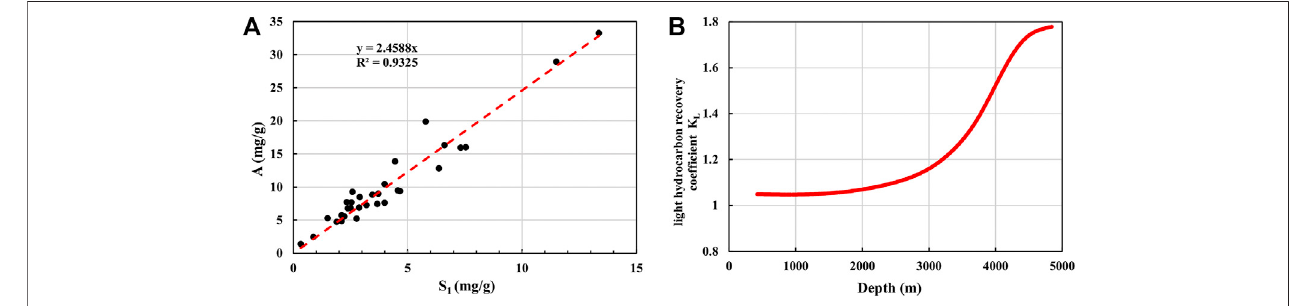
FIGURE 5 | Heavy hydrocarbon recovery coef fi cient (A) and light hydrocarbon recovery coef fi cient (B) [modi fi ed after Zhu et al. (2015)]